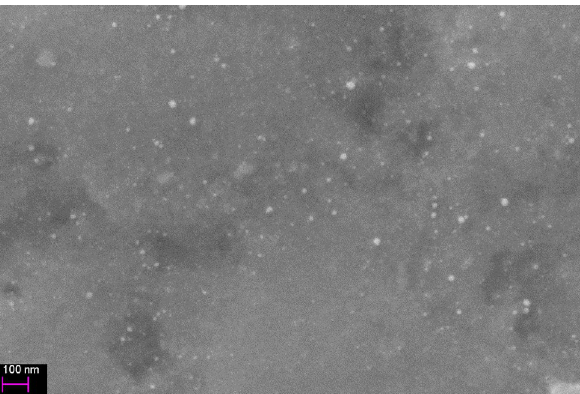
Figure 3. SEM Image of PAL silver nanoparticles, provided by the supplier. Observation has been made on scanning electron microscope LEO 1530.